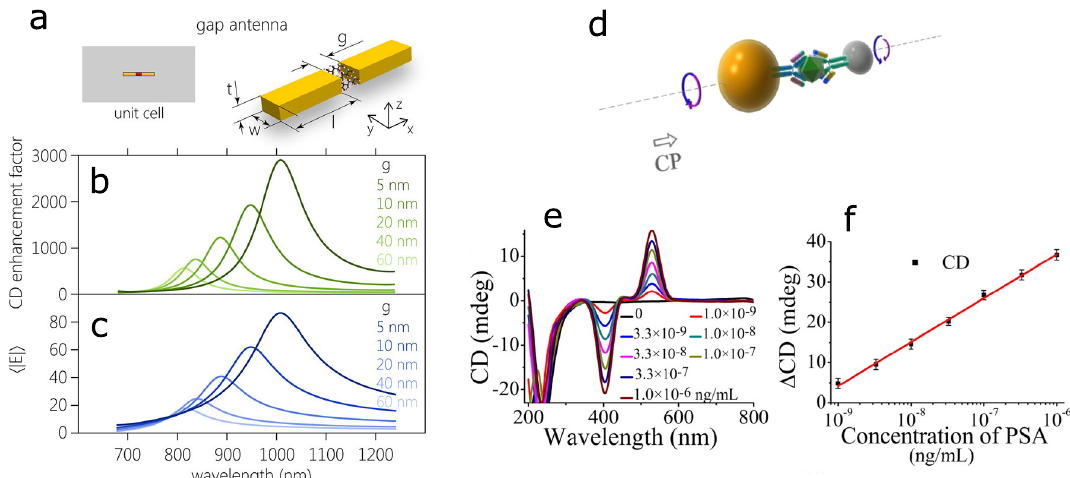
Figure 2. Chiral molecules in the gap of a plasmonic dimer: ( a – c ) theory and ( d – f ) experiment. ( a ) Schematics of gold nanorod dimer with chiral molecules immobilized in the gap; ( b ) calculated CD enhancement factor for different gap size; ( c ) corresponding values of average electric field in the gap volume. Reproduced with permission from Nesterov et al. [31] Copyright 2016 American Chemical Society. ( d ) Schematics of the Au–Ag heterodimer bridged by immunocomplex with prostate-specific antigen (PSA); ( e ) the CD spectra for different concentrations of PSA; ( f ) the CD calibration curve for PSA detection as a function of logarithmic PSA concentrations. Reproduced with permission from Wu et al. [32] Copyright 2013 American Chemical